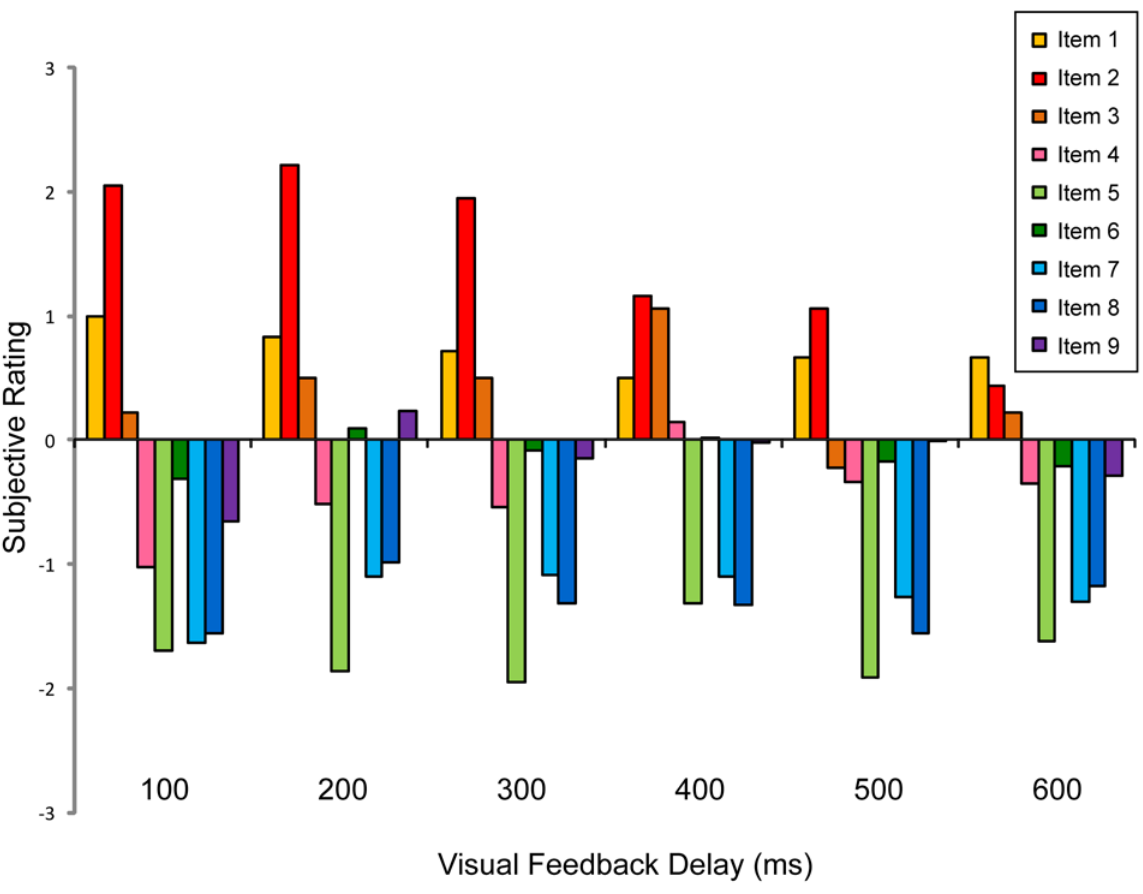
Figure 2. Subjective rating on questionnaire item 1–9 as a function of visual feedback delay length. First three items (1–3) were regarded as indicators of occurrence of RHI.